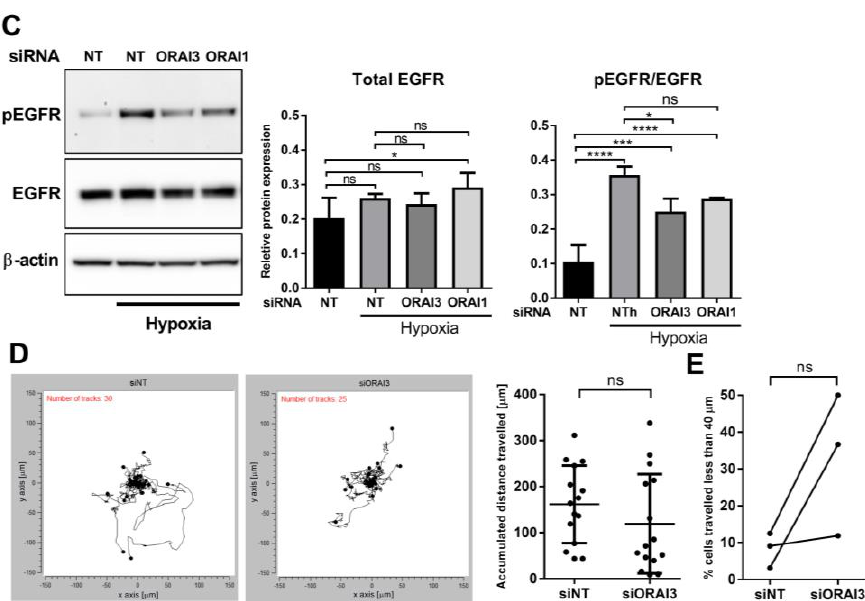
Figure 4. Effect of ORAI3 silencing on the levels of hypoxia-induced expression of EMT markers, EGFR activation and cell migration of MDA-MB-468 breast cancer cells. ( A ) Representative immunoblot (left) and densitometry analysis (right) of the effect of ORAI3 and ORAI1 silencing on hypoxia-induced vimentin protein expression and ( B ) the effect of ORAI3 silencing on the mRNA expression of key hypoxia-induced EMT markers in MDA-MB-468 breast cancer cells. ( C ) Representative immunoblot (left) and densitometry analysis (right) of the effect of ORAI3 and ORAI1 silencing on the total levels of EGFR protein and hypoxia-induced EGFR phosphorylation. ns = not significant ( p ≥ 0.05), * p < 0.05, ** p < 0.01, *** p < 0.001, **** p < 0.0001, (one-way ANOVA, with Tukey’s multiple comparisons), n = 3, mean ± SD. ( D ) Representative spatial plot of all NT control- and ORAI3-silenced cells from one well of the same experiment (left) and quantitative analysis of the distance travelled by 15 randomly selected cells from three independent experiments (5 cells from each experiment). ( E ) Quantitative analysis of the percent of cells in each experiment from three independent experiments that travelled less than 40 µ m. Total number of cells from three independent experiments analyzed were 95 and 80 cells for siNT and siORAI3, respectively. Cell migration was analysed in hypoxic conditions over a period of 12 h after exposing cells to 72 h hypoxia. ns = not significant ( p ≥ 0.05) (Mann-Whitney U -test), n = 3, mean ±